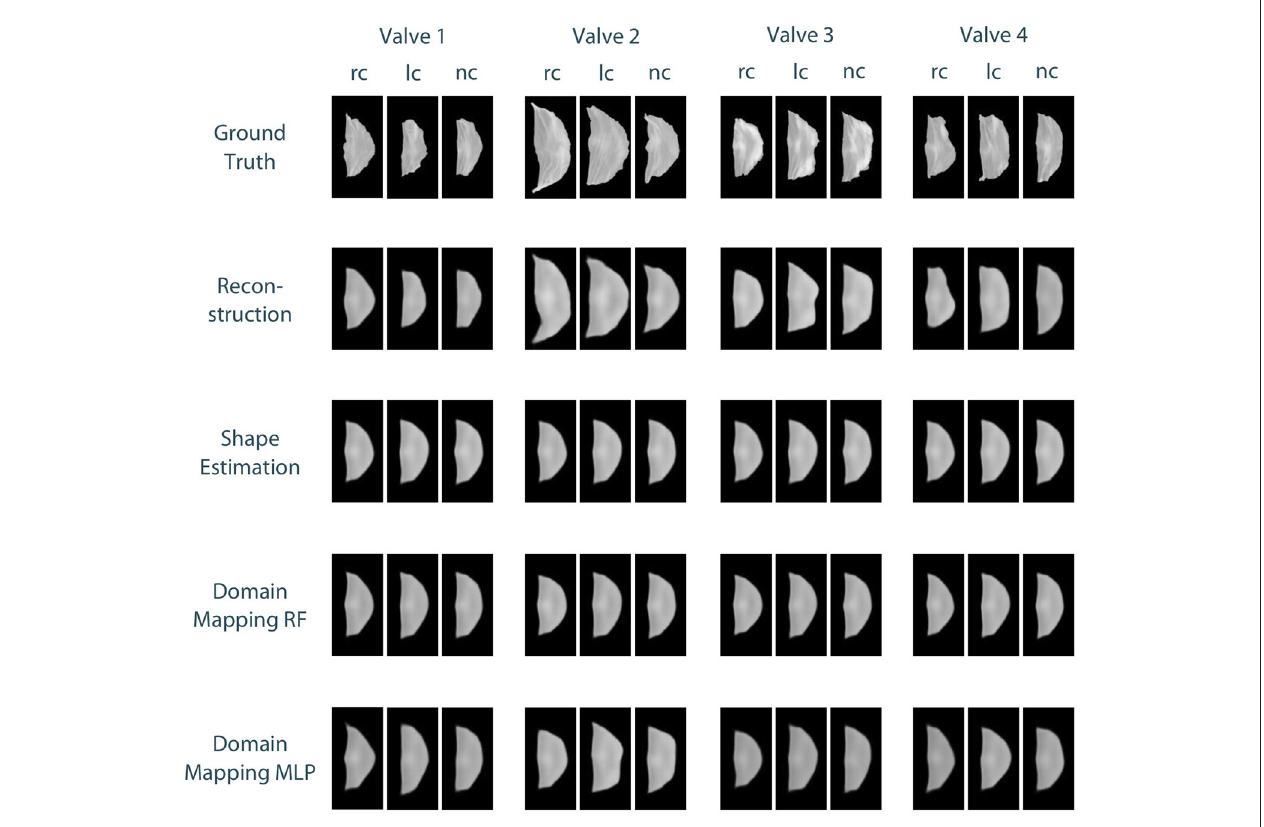
FIGURE 7 | Qualitative results for leaflet shape synthesis with a geometric prior, exemplarily given for four valves (columns) with their right-coronary (rc), left-coronary (lc), and non-coronary (nc) leaflet, respectively. The rows show the ground truth, the reconstruction of the ground truth after propagating it through the whole autoencoder, as well as the synthetic leaflets produced by the different approaches, i.e., shape estimation, domain mapping with random forests, and domain mapping with multilayer perceptrons. All four valves were drawn from the test set of one fold of the